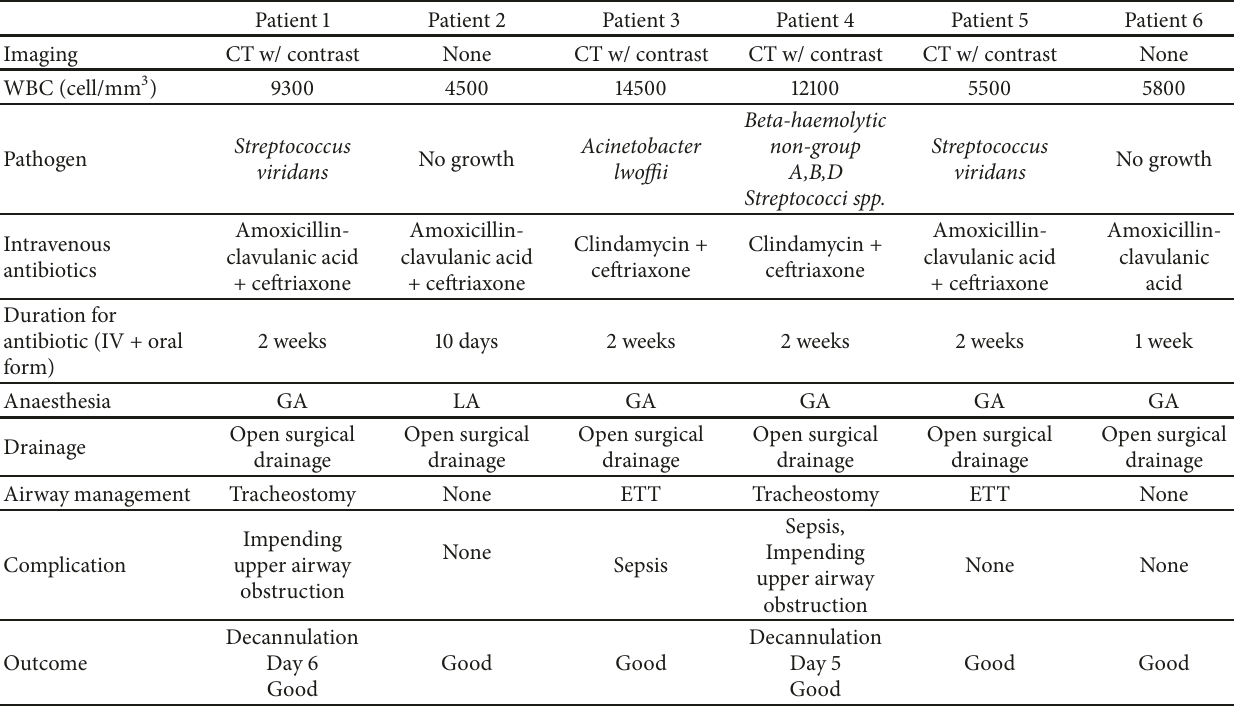
Table 2: Investigation, management, and clinical